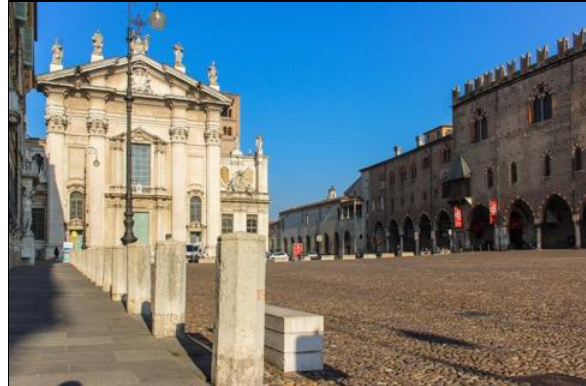
Figure 7. Example of an extended physical barrier: the materials and the excessive slopes of Sordello Square area a source of great inconvenience and danger for people with